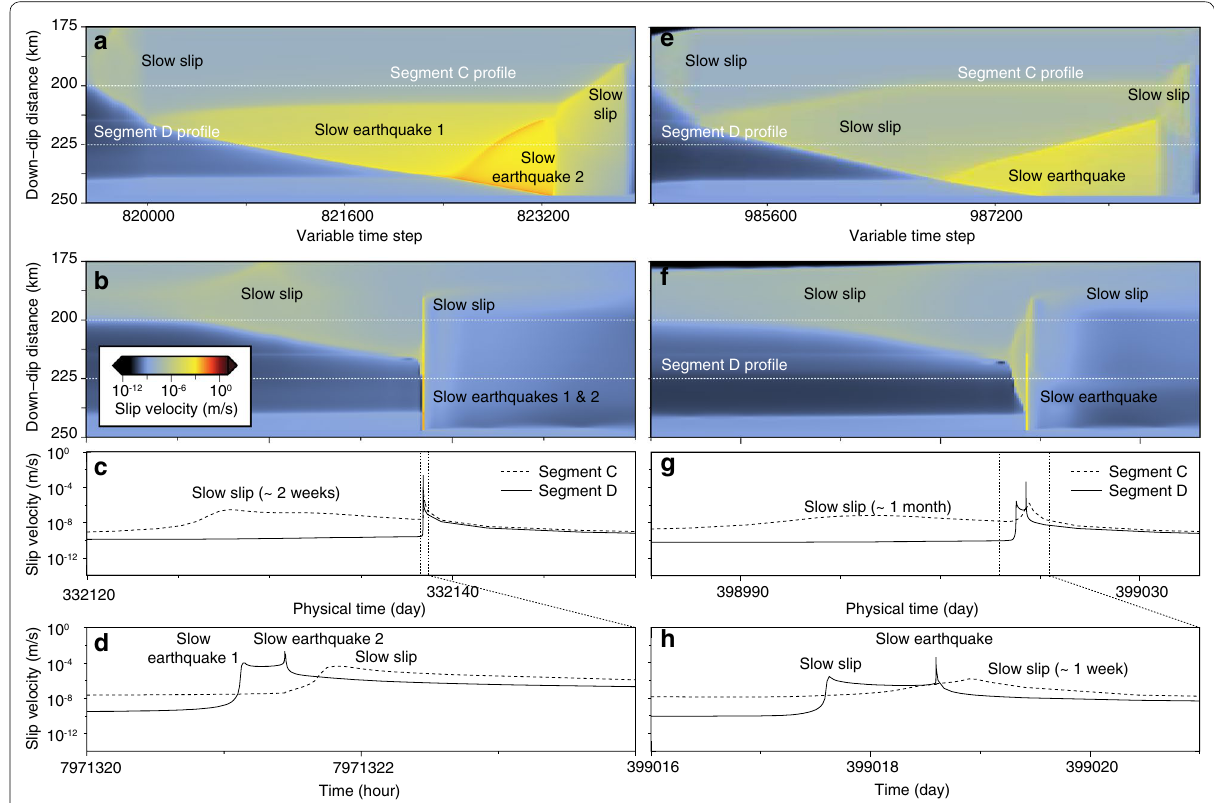
Fig. 5 Propagation and triggering of two sequences of deep slow slip and slow earthquakes. The first ( a – d ) and second ( e – h ) sequences start at about 910 and 1093 years, respectively. During each of the two sequences, fault dynamics of the same time window are plotted as a function of variable time steps ( a , e ) and physical time ( b , f ). In both cases, the long-term slow slip in segment C propagates down-dip and triggers a slow rupture near the segment boundary. The slow rupture further expands down-dip and triggers a faster rupture at the bottom of the slow-slip zone. Slip velocities at the center of segment C (dashed profile) and segment D (solid profile) for these two sequences are plotted in c and g , respectively. d and h are enlarged time series surrounding the slow earthquakes in c and g , respectively. b and c share the same x -axis, while the enlarged d has a x-scale of hours. f and g share the same x